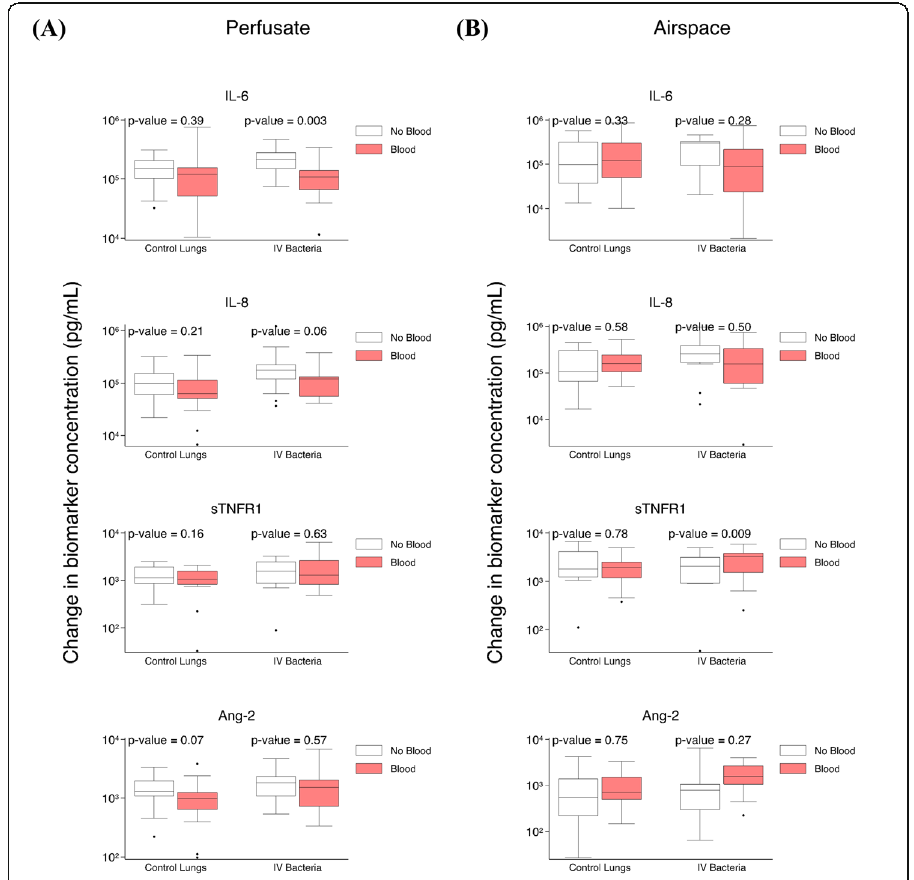
Fig. 3 Impact of exogenous blood on biomarker change after 4h of ex vivo lung perfusion. a Comparison of change in perfusate biomarker levels after 4h of ex vivo perfusion in control lungs in the presence ( n =21) or in the absence ( n =17) of exogenous blood, and in IV S. pneumoniae exposed lungs in the presence ( n =19) or in the absence ( n =22) of exogenous blood. b Comparison of change in airspace biomarker levels after 4h of ex vivo perfusion in control lungs in the presence ( n =16) or in the absence ( n =13) of exogenous blood, and in IV S. pneumoniae -exposed lungs in the presence ( n =13) or in the absence ( n =14) of exogenous